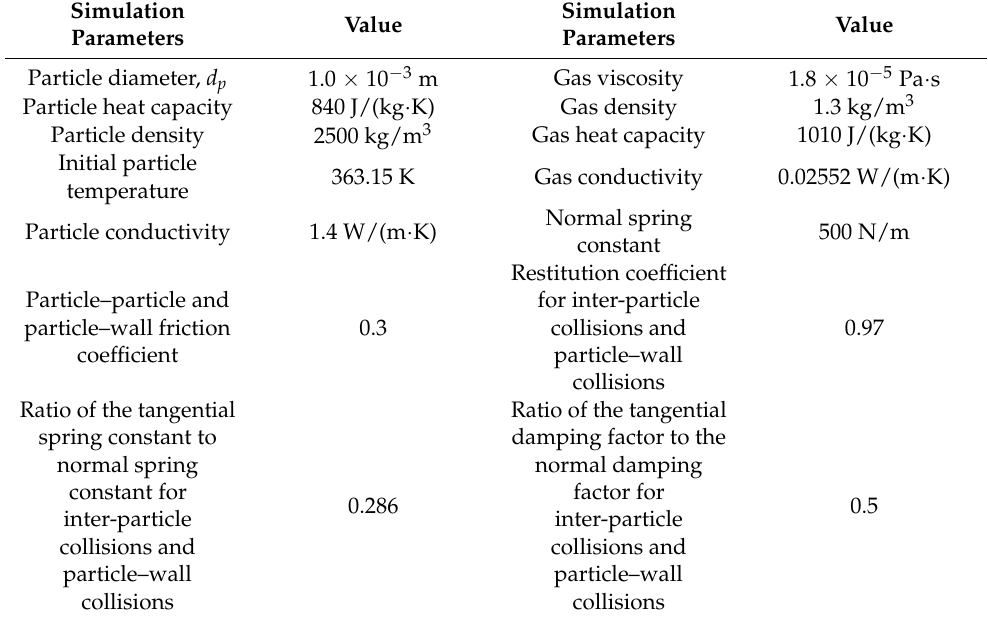
Table 1. Physical properties of the two